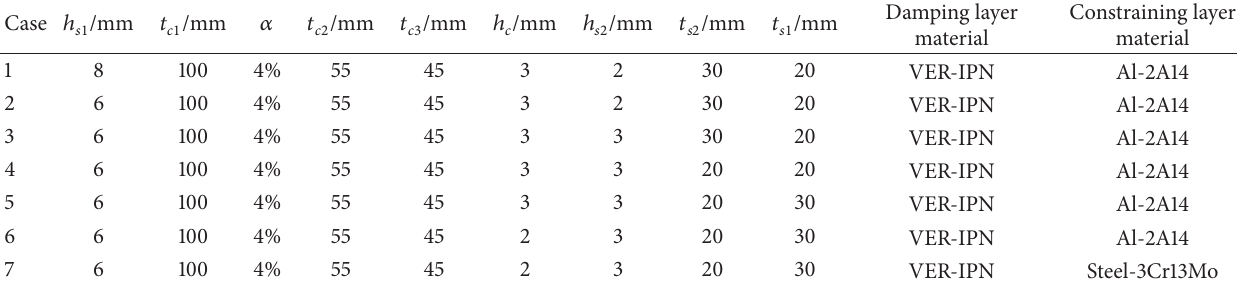
Table 1: Tests of the material and